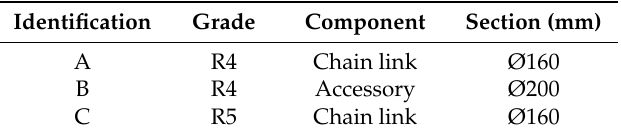
Table 3. Verification of the strength grade of the three materials, including the extended uncertainty for each measurement (K = 2).